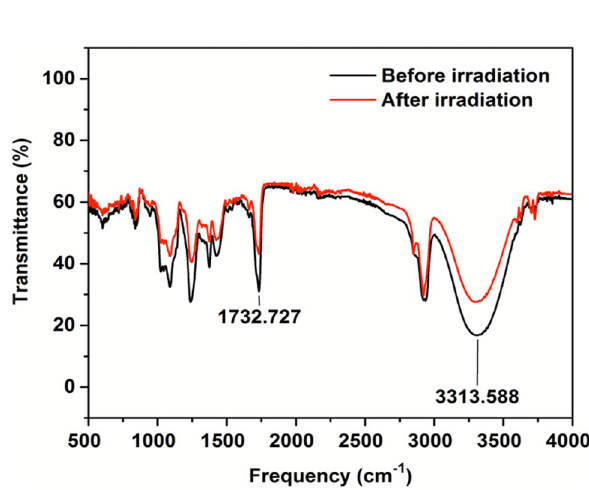
Figure 4. FTIR-ATR of film dosimeter DA 8 before and after NB UVB radiation exposure.